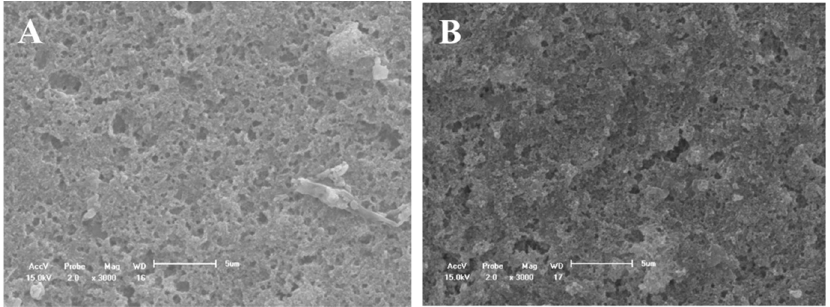
Figure 4. SEM-micrographs of the dentine surface morphology at 3000× magnification. ( A ) adhesive with nanofiber and ( B ) after 6% citric acid challenge. No changes were observed after acid challenge ( B ).